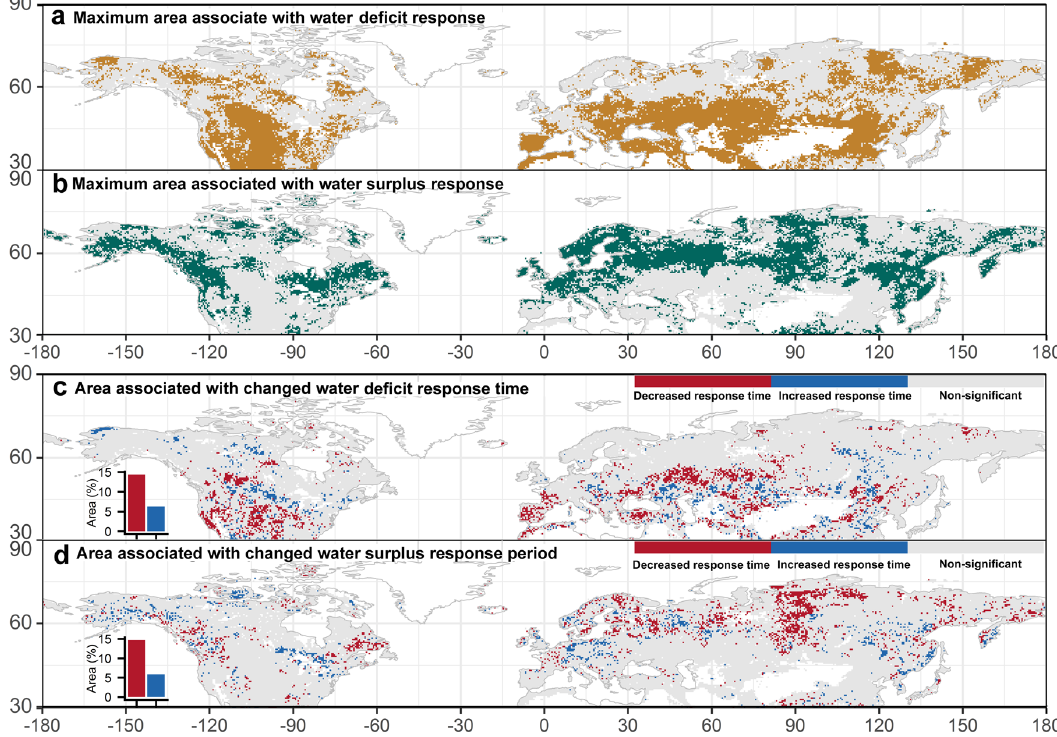
Fig. 3 Geographical distribution of maximum areas associated with water surplus and water de fi cit responses as well as the areas associated with changed response times to water surplus and water de fi cit over the last three decades. a Presents the maximum area composite of signi fi cant positive correlation (water de fi cit response) between normalized difference vegetation index (NDVI) anomaly and Standardized Precipitation-Evapotranspiration Index (SPEIs) from 1- to 24-month time-scale (gold color); b the maximum area composite of signi fi cant negative correlation (water surplus response) between NDVI anomaly and SPEIs from 1- to 24-month time-scale (green color); c area associated with change of response time to water de fi cit; d area associated with change of response time to water surplus response. The red and blue bars in ( c , d ) represent the areas of decreased and increased response time,